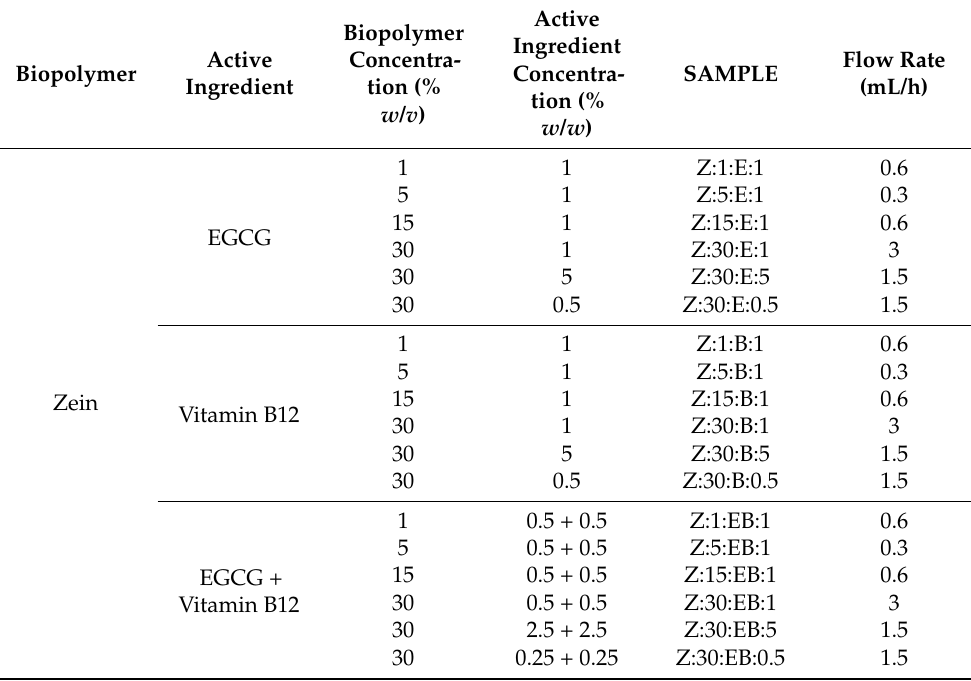
Table 4. Description of the solution conditions tested in electrospinning process for the samples containing EGCG and the samples containing Vitamin